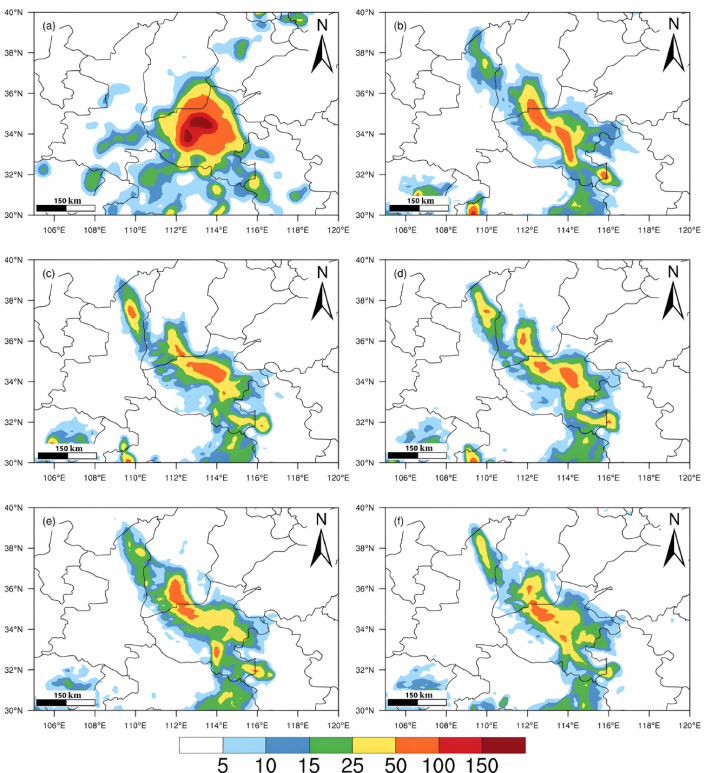
Figure 6. The 24 h cumulative rainfall (unit: mm) from 00:00 to 23:00 on 19 July with a model start time of 00:00 on the 18th: ( a ) measured rainfall, ( b ) exp0, ( c ) exp1, ( d ) exp2, ( e ) exp3, and ( f )